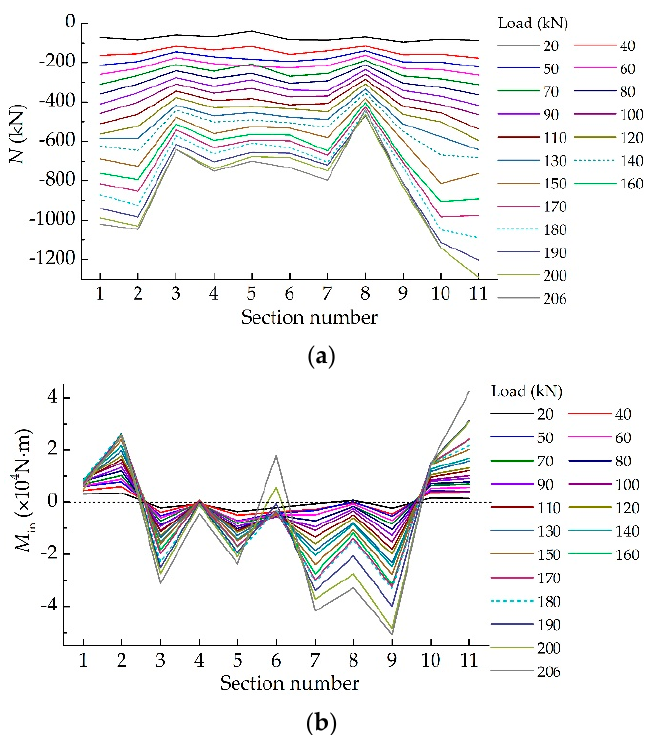
Figure 12. The stressing state submodes for internal forces of arch-A: ( a ) The distribution mode of N ; ( b ) the distribution mode of M in .